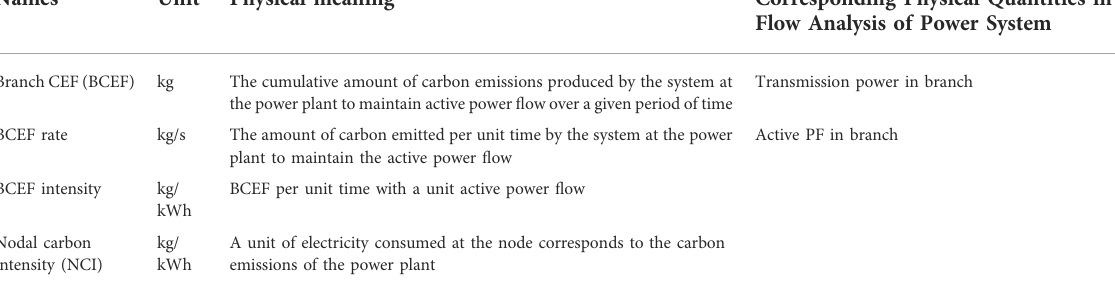
TABLE 1 THE basic physical quantities of CEF analysis.